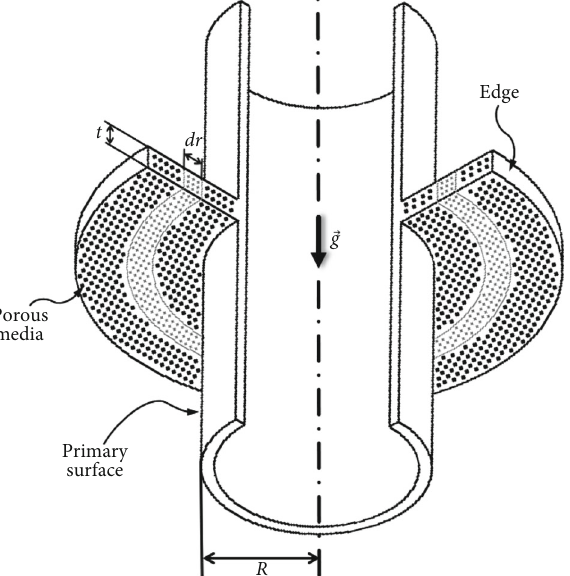
Figure 1: Radial porous fi